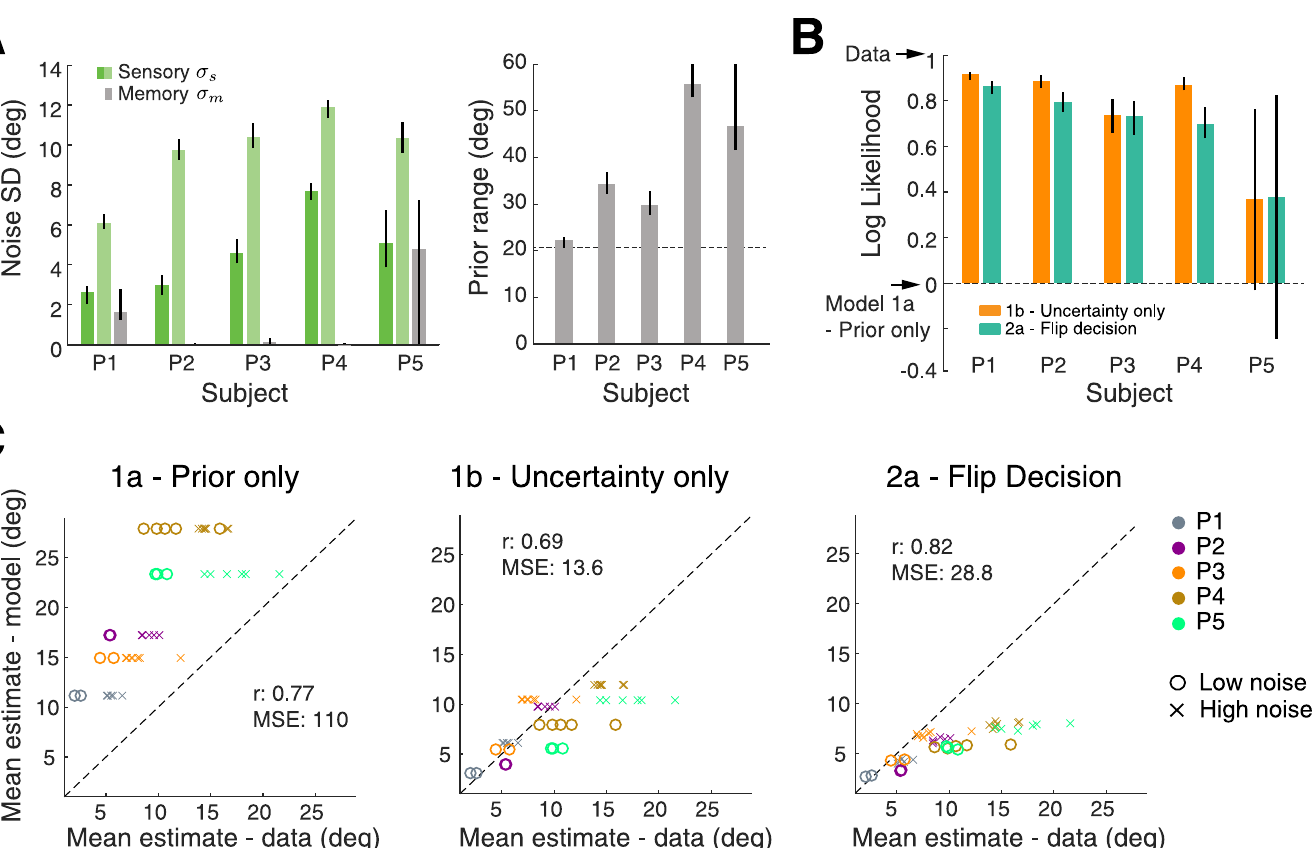
Fig 5. Experiment 1—Fit model parameters and prediction accuracy for individual subjects. (A) Fit noise levels and prior widths. While there is substantial inter- subject variability, the range of parameters values is consistent with our previous study [10]. (B) Log-likelihood comparison between the models. Values are normalized relative to the log-likelihood values of Model 1a (prior only) and the ‘omniscient’ model (‘Data’—i.e. the likelihood value based on the empirical probabilities; see Methods for details). Model 1a performs substantially worse than the other models for all subjects. However, log-likelihoods for Models 1b and 2a are not statistically different except for subject P4. All errorbars in (A) and (B) indicate 95% confidence intervals computed over 200 bootstrapped samples. (C) Scatter plots comparing the mean estimates between models and data. Each point corresponds to one experimental condition (stimulus noise and orientation) of one subject. Although all models can approximately explain the trend in data, the predictions of Model 1a are substantially off. Compared to Model 1b, Model 2a has a higher correlation but is worse when comparing mean-squared error (MSE) between model and data mean. Model 2a (flip decision) tends to underestimate the magnitude of subjects’ estimates proportional to stimulus